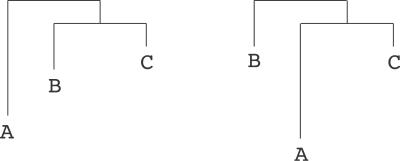
Sampling of Tree TopologiesThe topology of the tree on the left gets modified into the tree on the right by swapping an aunt (A) and its niece (B). Nice–aunt swapping has been shown to be ergodic.